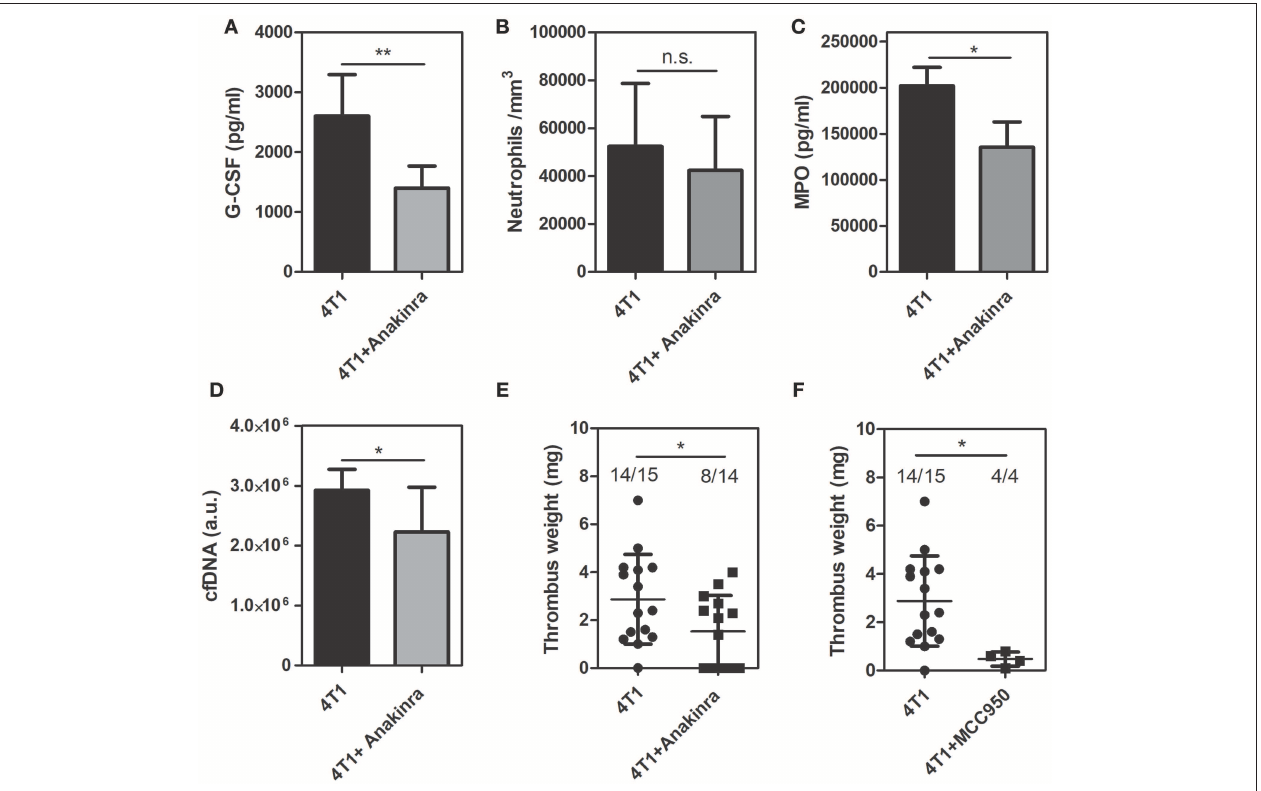
FIGURE 5 | Inhibition of IL-1R decreases DVT in 4T1 tumor-bearing mice. (A) Systemic levels of G-CSF in 4T1 tumor-bearing mice (black bars, n = 5) and 4T1 tumor-bearing mice treated with anakinra (gray bars, n = 6) were assessed by a specific ELISA kit as described in section Materials and Methods. (B) The neutrophil count in mice with 4T1 (black bars, n = 11) or anakinra-treated 4T1 (gray bars, n = 7) tumors was evaluated as described in section Materials and Methods. Two systemic markers of NETs, MPO (C) and cfDNA (D) , were analyzed in 4T1 tumor-bearing mice (black bars, n = 6) and 4T1 tumor-bearing mice treated with the IL-1R antagonist (gray bars, n = 6) as described in section Materials and Methods. For systemic analysis, the blood was collected 21 days after the tumor cell inoculation. (E) Venous thrombosis was evaluated with stasis of the inferior vena cava for 6h in 4T1 tumor-bearing mice (•, n = 15) and 4T1 tumor-bearing mice treated with anakinra ( (cid:4) , n = 14). (F) Alternatively, 4T1 tumor-bearing mice (•, n = 15) were treated with MCC950 (20 mg/kg/day, s.c.) ( (cid:4) , n = 4) for 8 days, between day 14 and day 21 after the tumor cell inoculation. Each dot represents one individual mouse. Values represent the mean ± SD. * P < 0.05 and ** P = 0.01; n.s., non-significant, unpaired two-tailed Student’s t